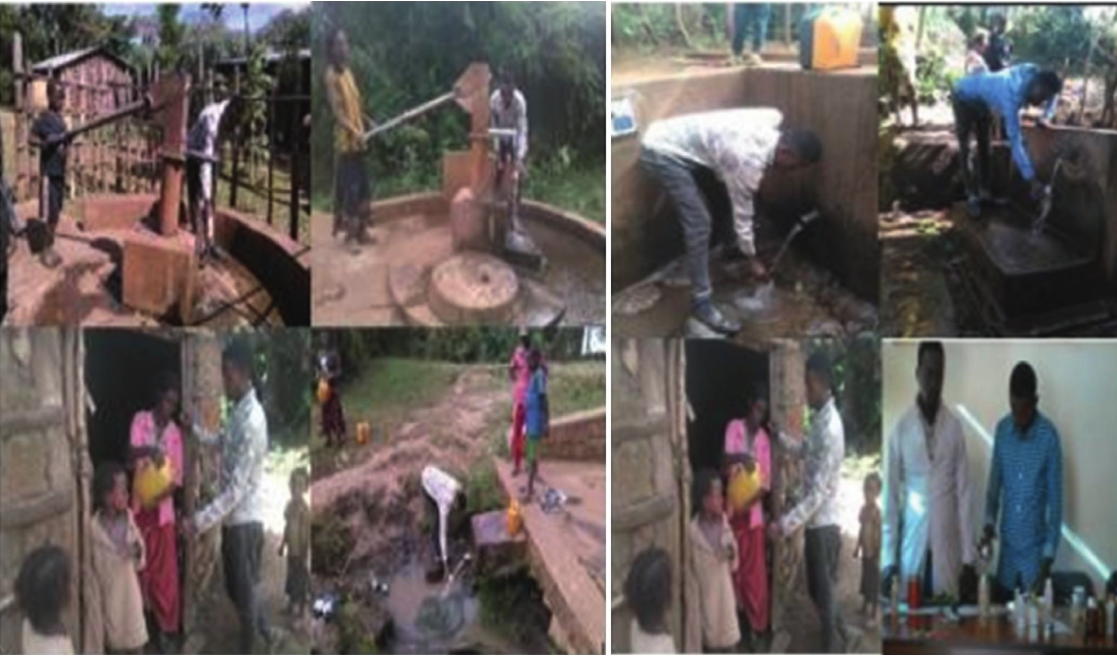
Figure 2: Water sampling and quality testing at a water quality